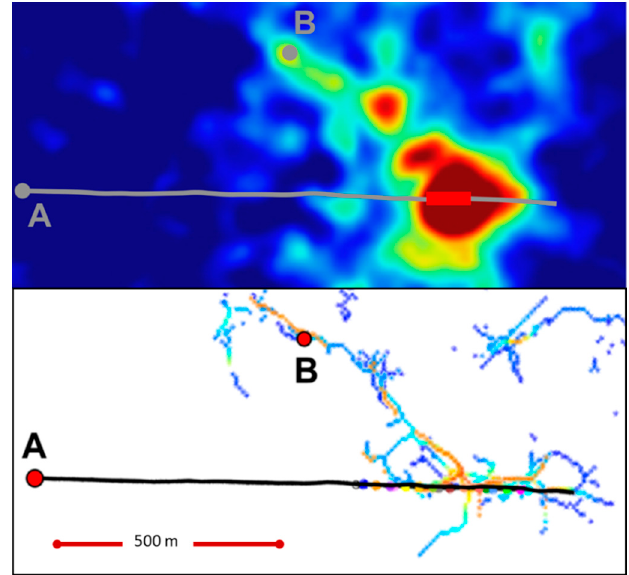
Figure 1. ( Top ) A horizontal map slice of the above background Fracture Seismic (FS) intensity (red high, blue low), activated during the third stage of a fracture stimulation treatment. ( Bottom ) The above-background FS intensity (red high, blue low) backbone of the same horizontal map slice in the FS intensity cloud for hydrofracturing Stages 3–5. Point A is the wellhead of a horizontal well with a trajectory indicted by the black line. Point B shows the location of a vertical well with pressure and chemical tracer monitors. Both pressure and tracer communicated between Well B and Well A, where the FS skeleton connects the wells over a distance of 600 m. Figure is from Lacazette et al (2013) [3].